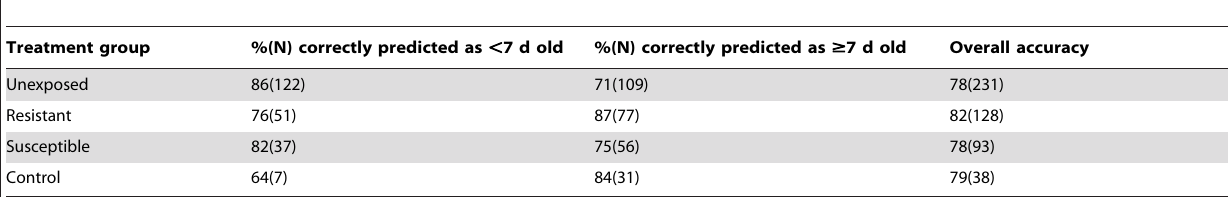
Table 1. Percentage accuracy of the NIRS technique for predicting the age of mixed- Anopheles spp at each treatment level correctly as , 7 or $ 7 d old.